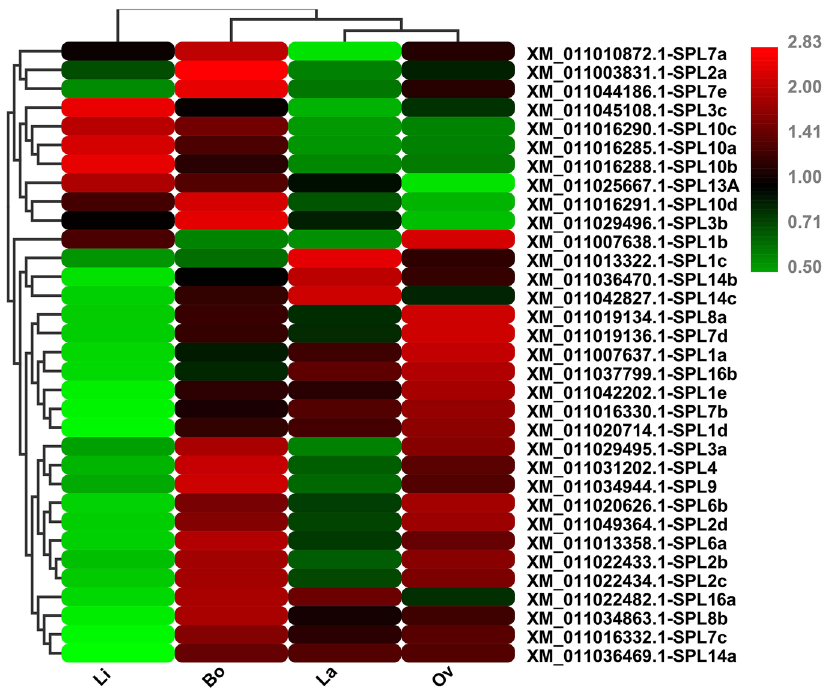
Figure 3. Heatmap representation of SPL gene expression in P. hl. FPKM values were identified from RNA- seq data and normalized by log 2 transformation. The color scale represents log 2 -transformed values. Green represents low expression, and red represents high expression. This figure was generated with HEATMAP (https:// www. omics hare. com/ tools/ Home/ Soft/ heatm ap).